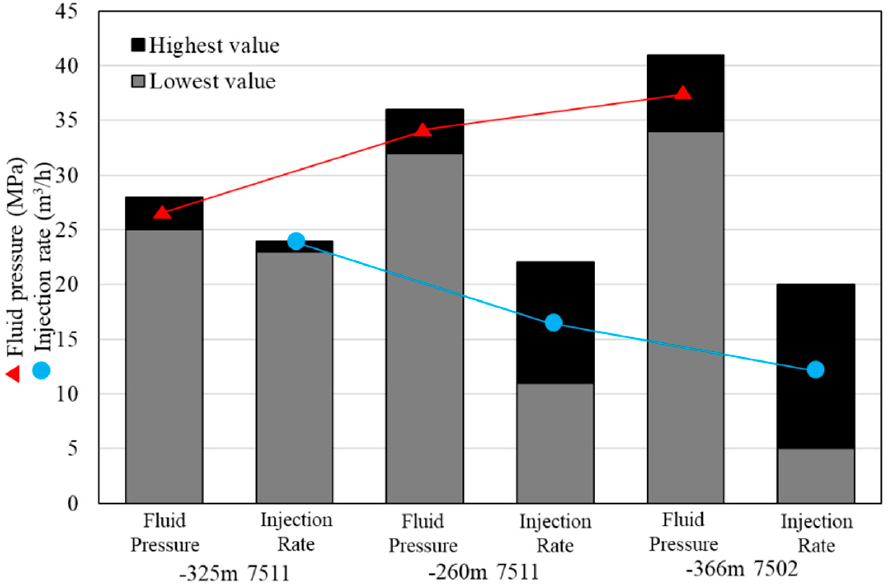
Figure 6. Operating parameters of hydraulic fracturing in the three districts.